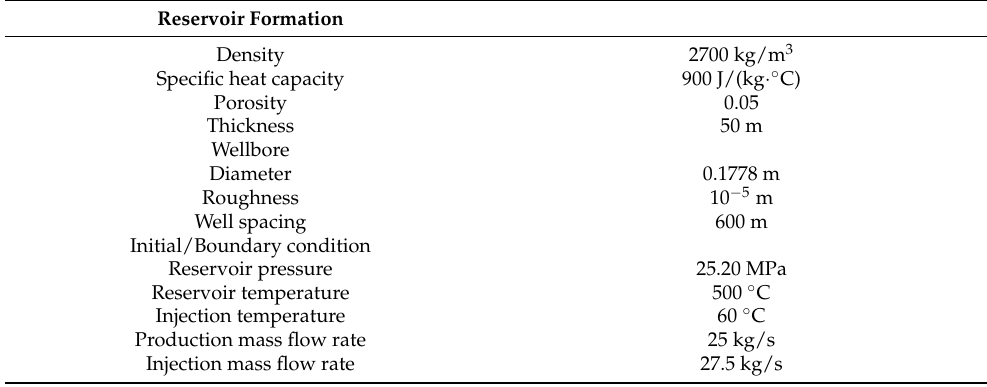
Table 1. Thermo-physical parameters and initial/boundary conditions for the numerical simulation.